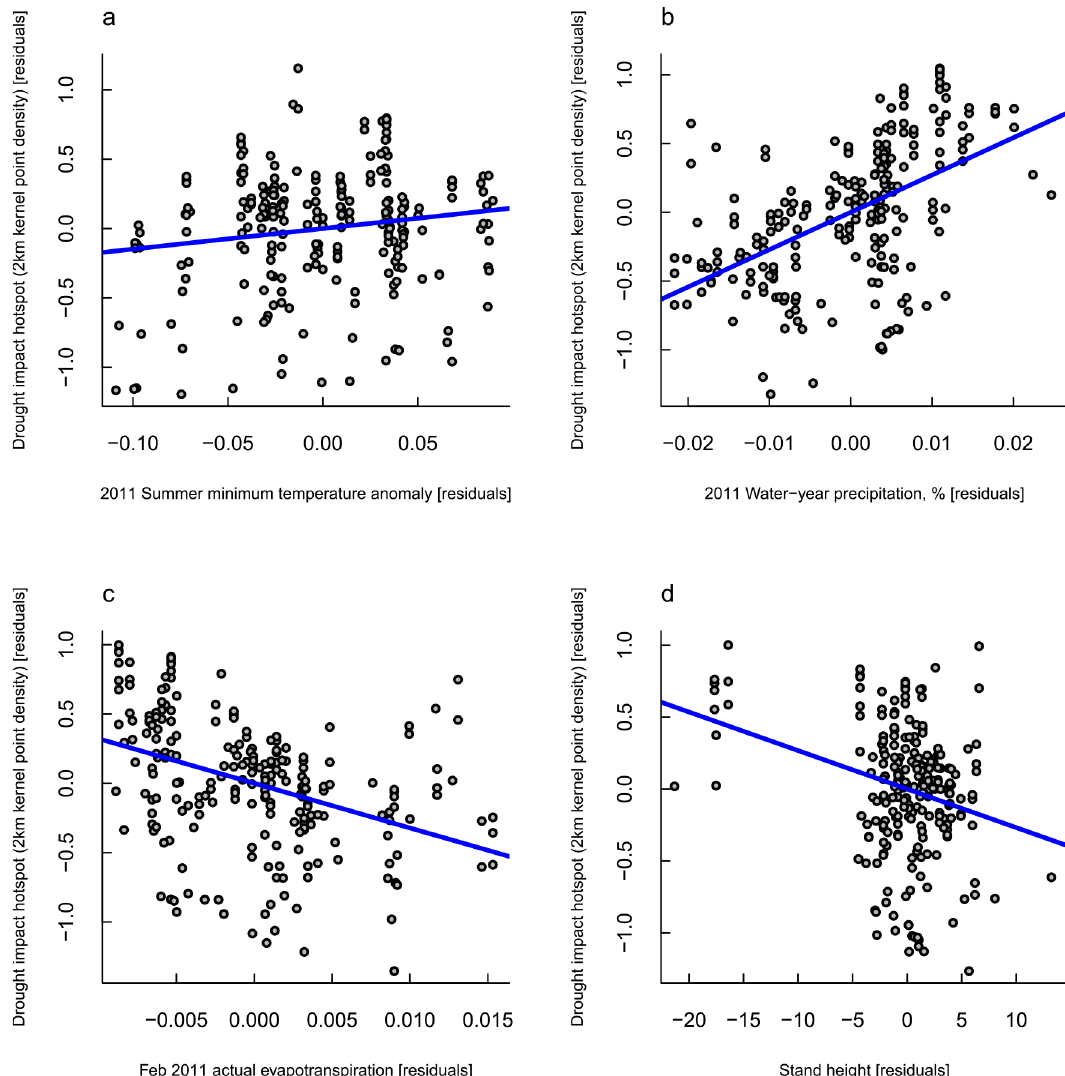
Fig 5. Partial-regression plots from the final regression model of drought impact patch clustering as a function of environmental variables related to water availability: Each panel plots the independent effects of (a) summertime average daily temperature minima at the time of the drought, expressed as an anomaly from the long-term mean; (b) annual precipitation in the drought year, expressed as a percentage of the long-term mean; (c) actual evapotranspiration in the month of the canopy dieback event; and (d) stand